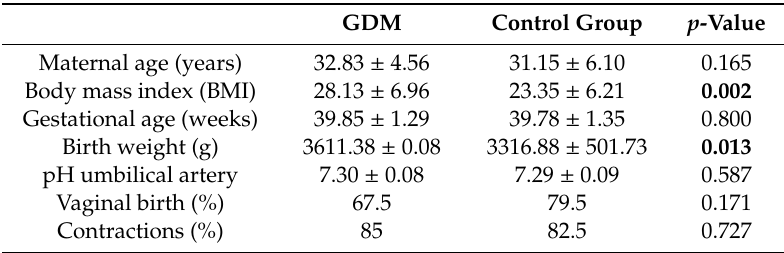
Table 3. Demographic and clinical characteristics of the study population. The values are listed as mean ± SD. Significant p -values are written in